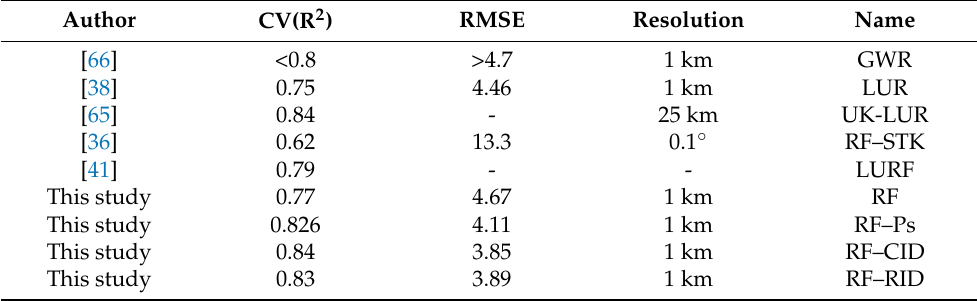
Table 3. Comparison of the effects of the spatial distribution of the NO 2 concentration